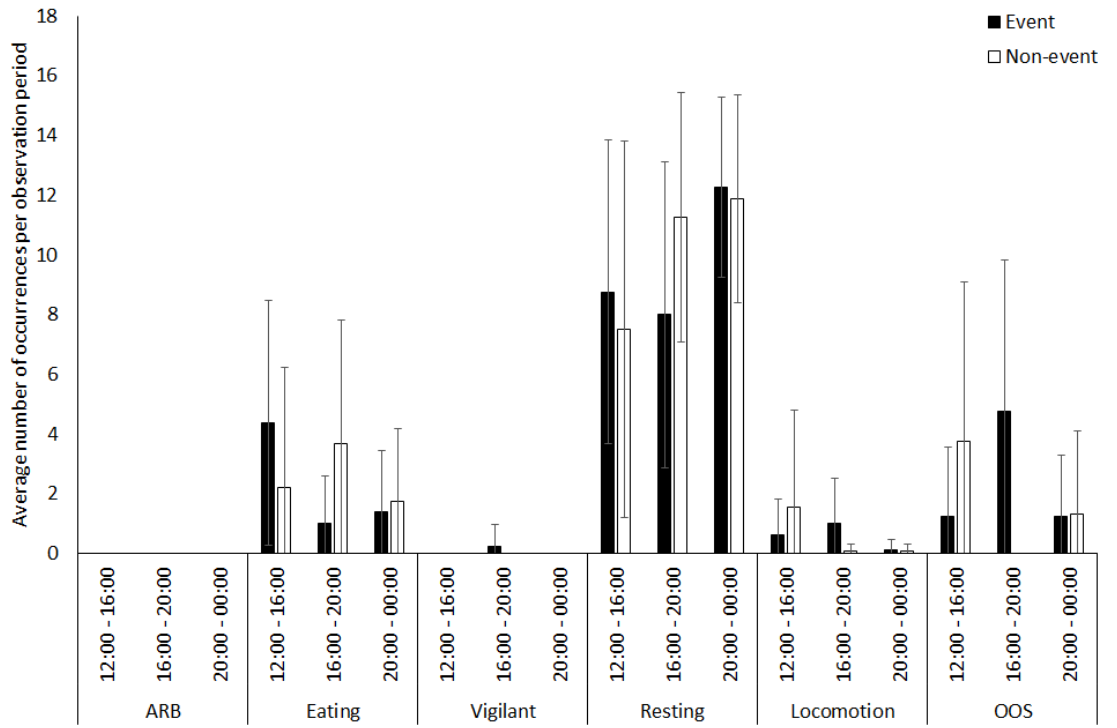
Figure 7. Activity budget data for three tapir (average number of occurrences of each behaviours within the group per observation period ± standard deviation) from 12:00–00:00 during event nights and non-event nights. Each 12 h period was split into three time periods. ARB: abnormal repetitive behaviour, OOS: out of sight of the observer. behaviour, OOS: out of sight of the